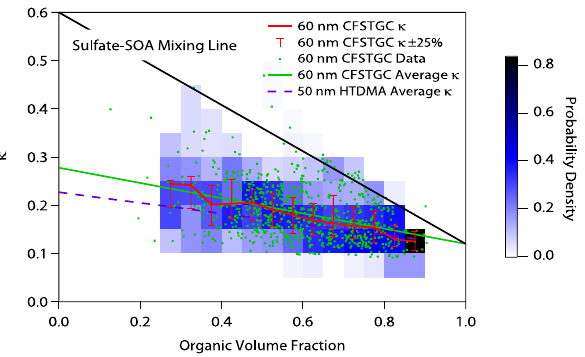
Fig. 9. 60nm CFSTGC-derived κ median values (red line) with bars showing 25th and 75th percentiles. Actual 60nm CFSTGC-derived κ values shown by green circles. Probability density for 60nm data is indicated by the blue shading. The black dashed line indicates the sulfate-SOA mixing line. The solid green line shows the average value of 60nm CFSTGC-derived κ as predicted by AMS closure while the dashed purple line shows the 50nm HTDMA-derived κ as predicted by AMS closure.